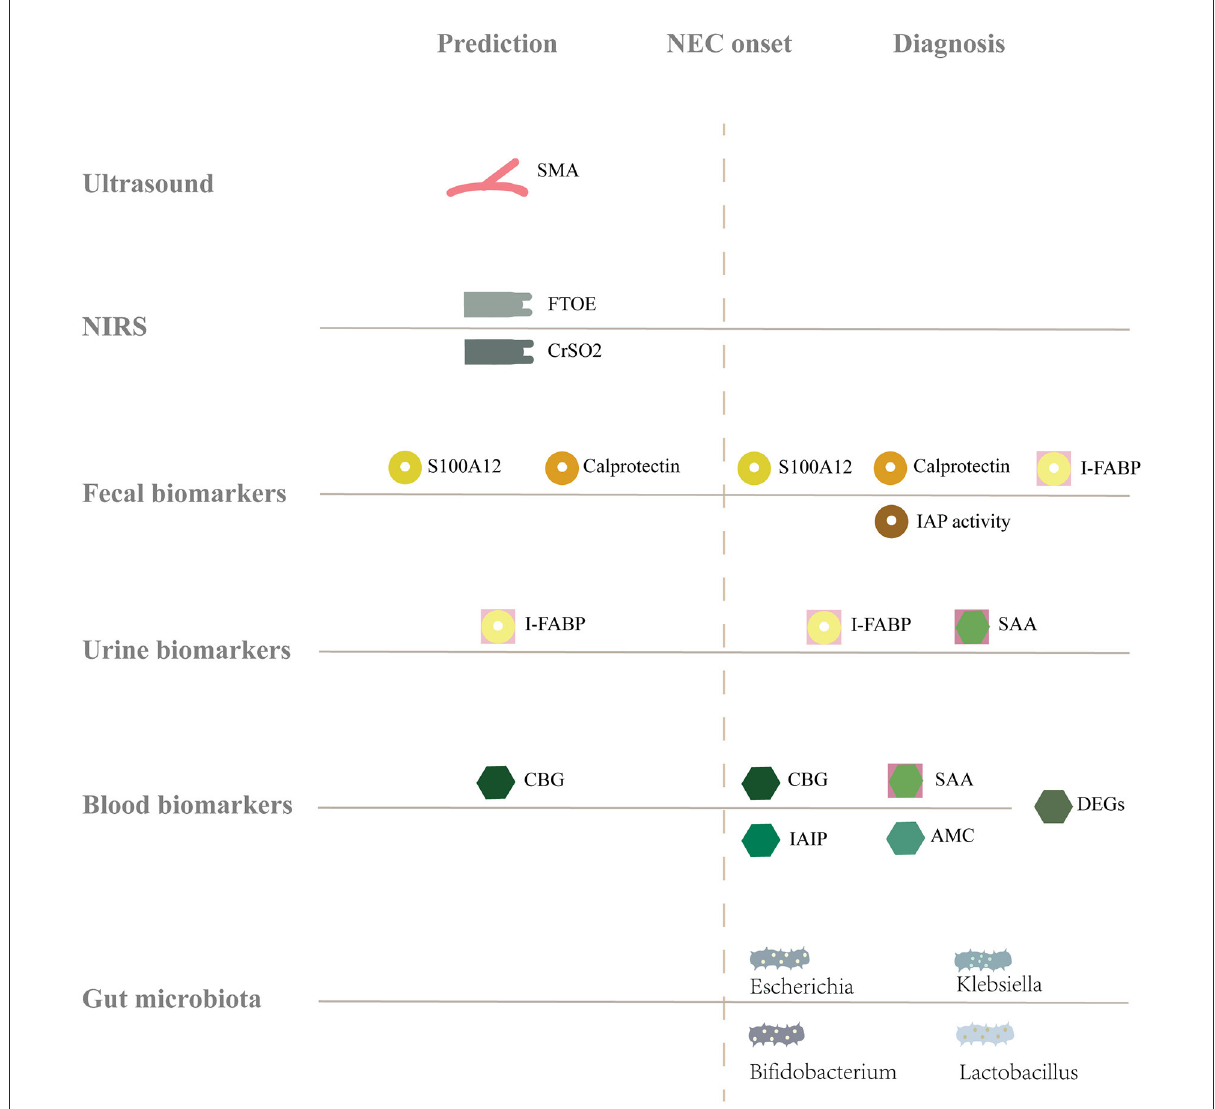
FIGURE1 Summary of the full text. The gray solid line represents the baseline level of healthy infants, and above, below, and after the solid line represents the increase, decrease and change of markers, respectively. NEC, Necrotizing enterocolitis; SMA, Superior mesenteric artery; NIRS, Near-infrared spectroscopy; FTOE, Fractional tissue oxygen extraction; CrSO2, Cerebral tissue oxygen saturation; S100A12, S 100 calcium binding protein a 12; I-FABP, Intestinal fatty acid binding proteins; IAP activity, Intestinal alkaline phosphatase activity; SAA, Serum amyloid A; CBG, Cytosolic β - glucosidase; DEGs, Differentially expressed genes; IAIP, Inter-alpha inhibitor proteins; AMC, Absolute monocyte